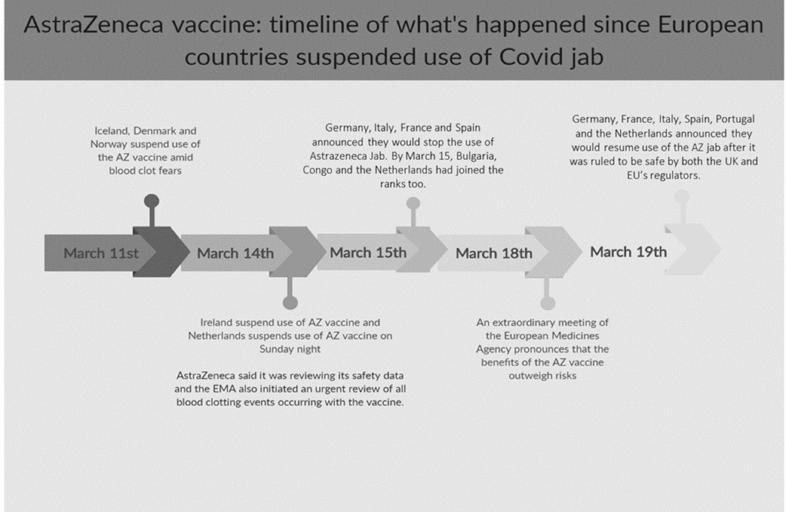
Figure 1. AstraZeneca vaccine: timeline of what happened since countries worldwide suspended the use of the AZ